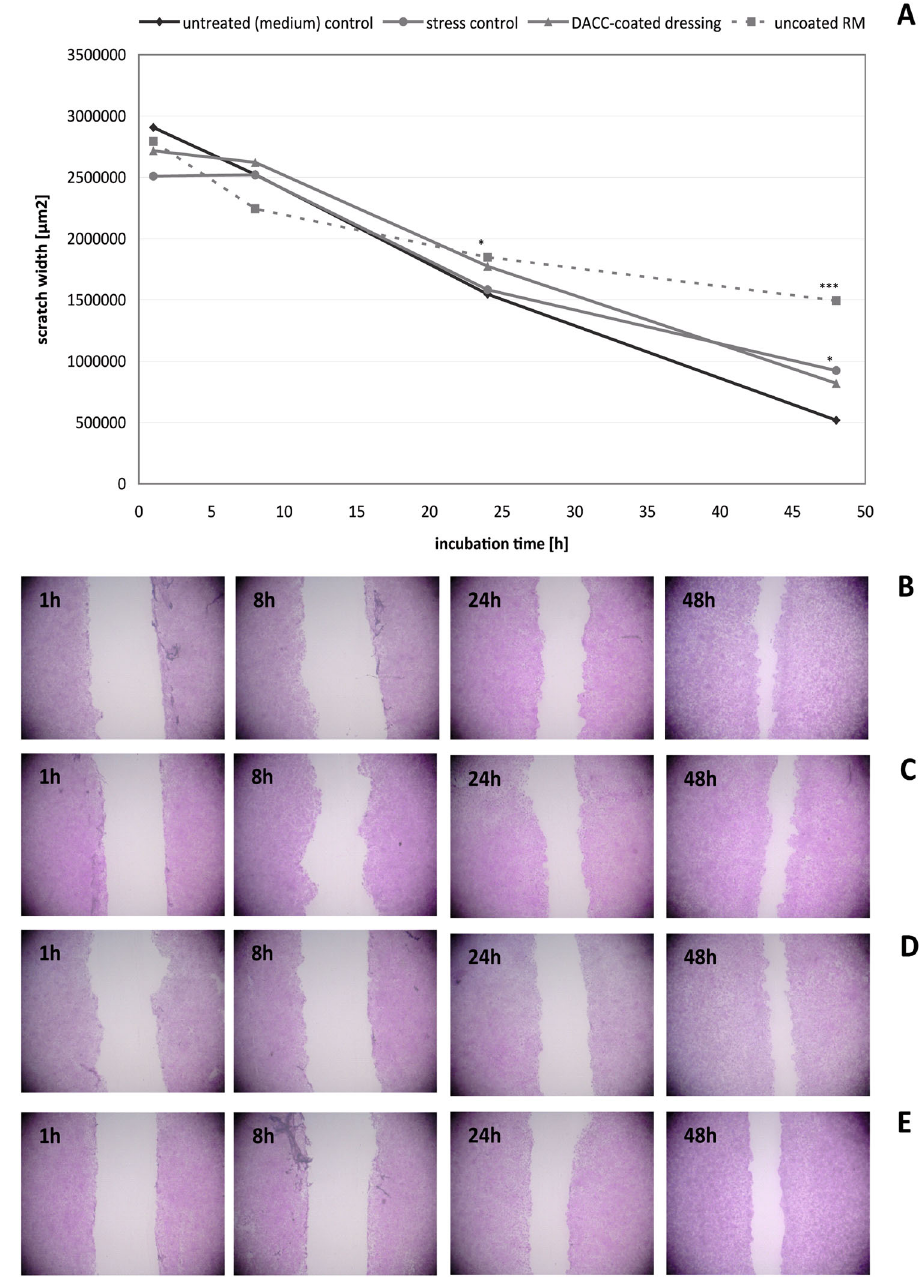
Fig. 3 Progression of HaCaT scratch healing ( A ) in the untreated (medium) control ( B ) and the stress control ( C ) as well as under treatment with DACC ( D ) and untreated RM ( E ) after 1, 8, 24, and 48 hours (h). Asterisks indicate a signi fi cant deviation at the respective time point from the untreated